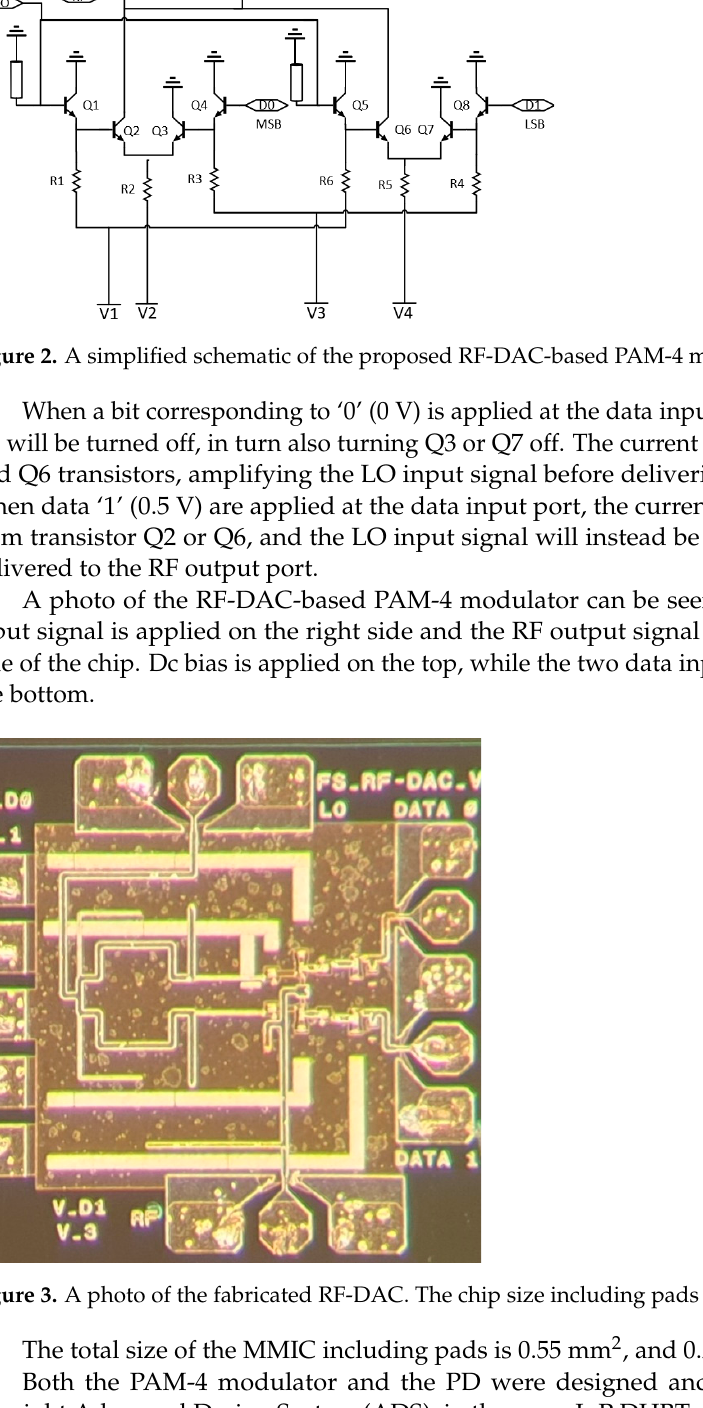
Figure 4. Simulated output power for different data input voltages of the MSB (D0), with dif- ferent input power (LO). The LSB (D1) is set to 0 V, and the LO frequency is 130 GHz. Measurement Results of the PAM-4 Modulator The PAM-4 modulator was measured in frequency domain, on-wafer, using a MPI TS200 probe station. The output S21 measurement was captured with an Anritsu VectorStar ME7838A vector network analyzer (VNA). A frequency sweep from 70 GHz to 130 GHz and 130 GHz to 170 GHz can be seen in Figure 5. The reason for the two separate measurements is that different VDI VNA extenders were used. The four dif- ferent traces represent the four different input data states of the PAM-4 modulator. The highest level corresponds to data input ‘00’, while the lowest level corresponds to data input ‘11’.